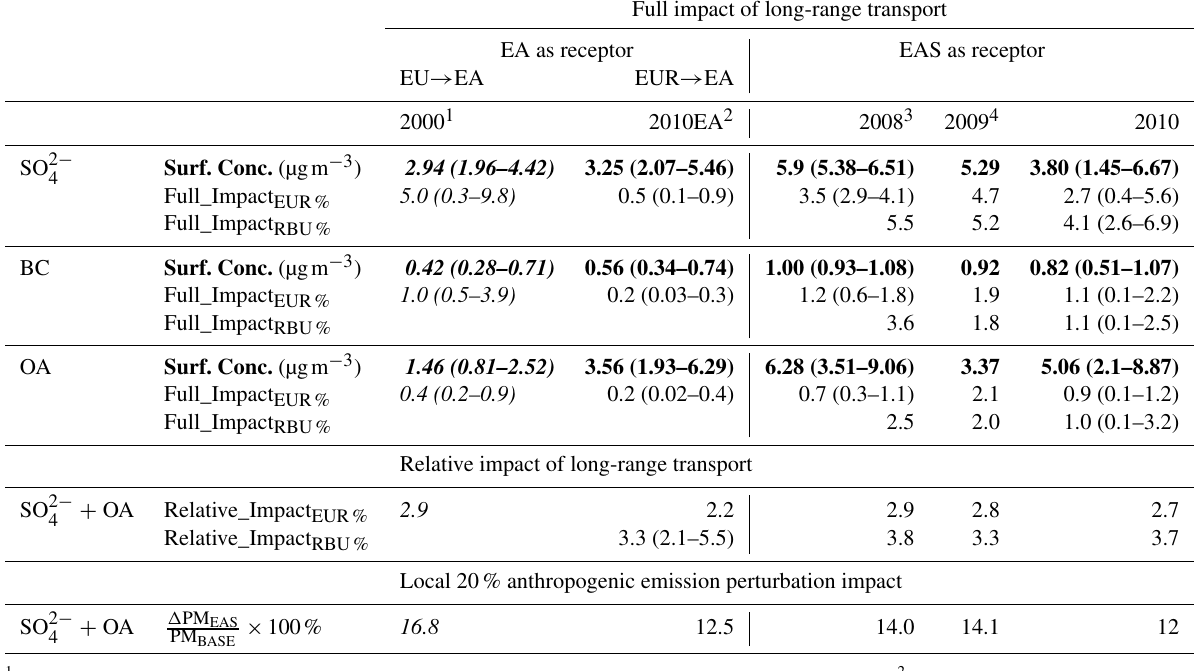
Table 2. Annual average long-range transport impacts of surface PM concentrations and percentage contributions from the EUR and RBU source regions to the EAS receptor region. Numbers collected from the HTAP1 assessment are presented in italic font; aerosol surface concentrations (Surf. Conc.) under the baseline scenario are presented in bold font. Numbers in the parentheses indicate the range of each variable among the participating